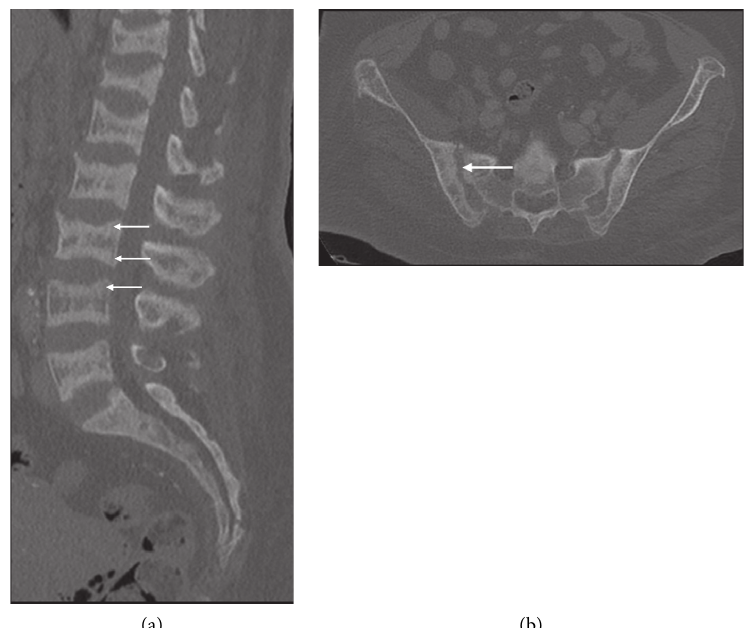
Figure 21: A 49-year-old female with end stage renal failure and tertiary hyperparathyroidism. Sagittal lumbar spine (a) with bone reconstructions shows rugger-jersey spine with sclerosis adjacent to end plates (arrow) whilst axial pelvis (b) demonstrates subperiosteal resorption of the SIJs